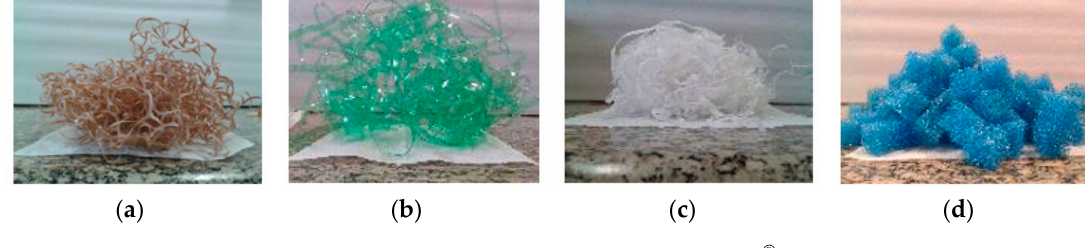
Table 2. Packing material characteristics [32].